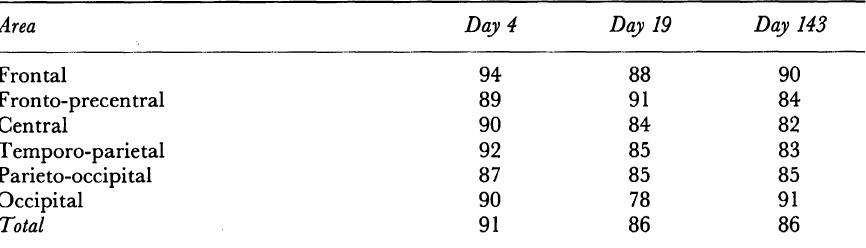
TABLE I. Percentage of the perfusion of the left hemisphere in relation to the right hemisphere as measured by SPECT for the regions separately calculated Area Day 4 Frontal 94 F ron to-precentral 89